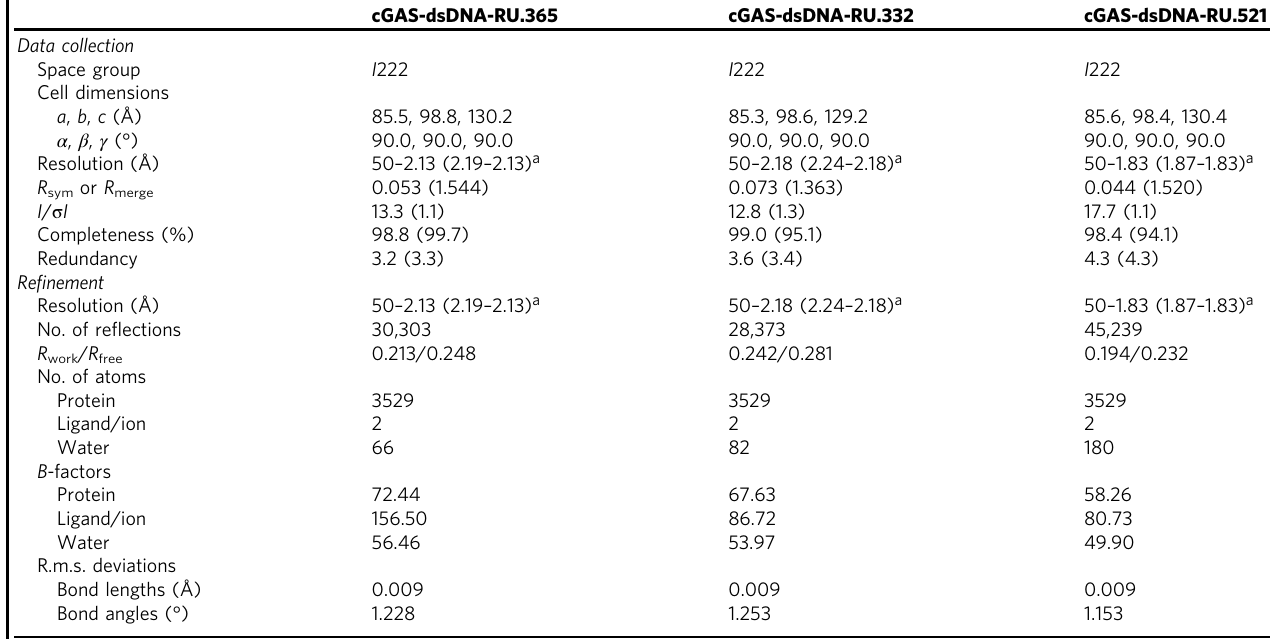
a One crystal for each structure; values in parentheses are for highest-resolution